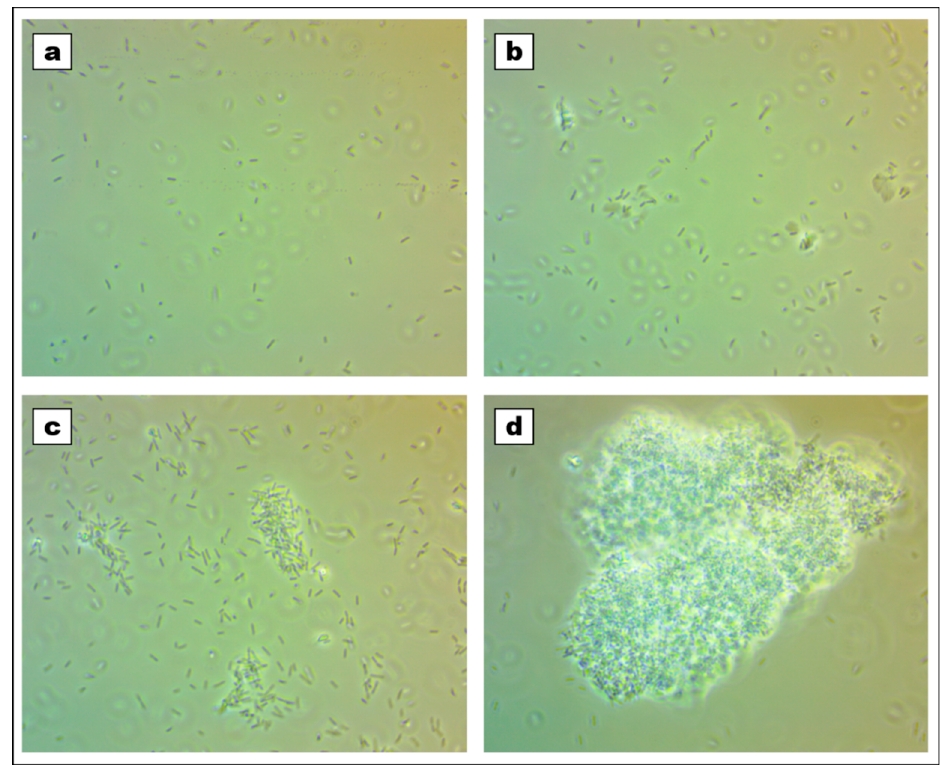
Figure 3. Microphotographs of bacteria in control sample ( a ) and after six hours of incubation with 0.01 mg/mL ( b ), 0.05 mg/mL ( c ), and 0.1 mg/mL ( d ) of titanium dioxide/silica nanotubes; magnification 1000×.